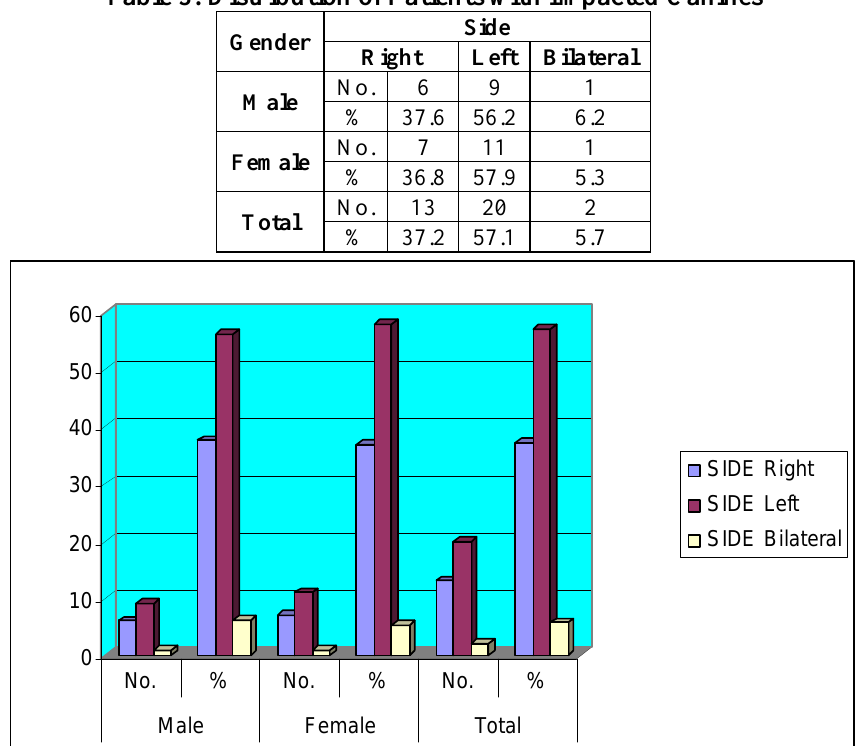
Table 3: Distribution of Patients with Impacted Canines